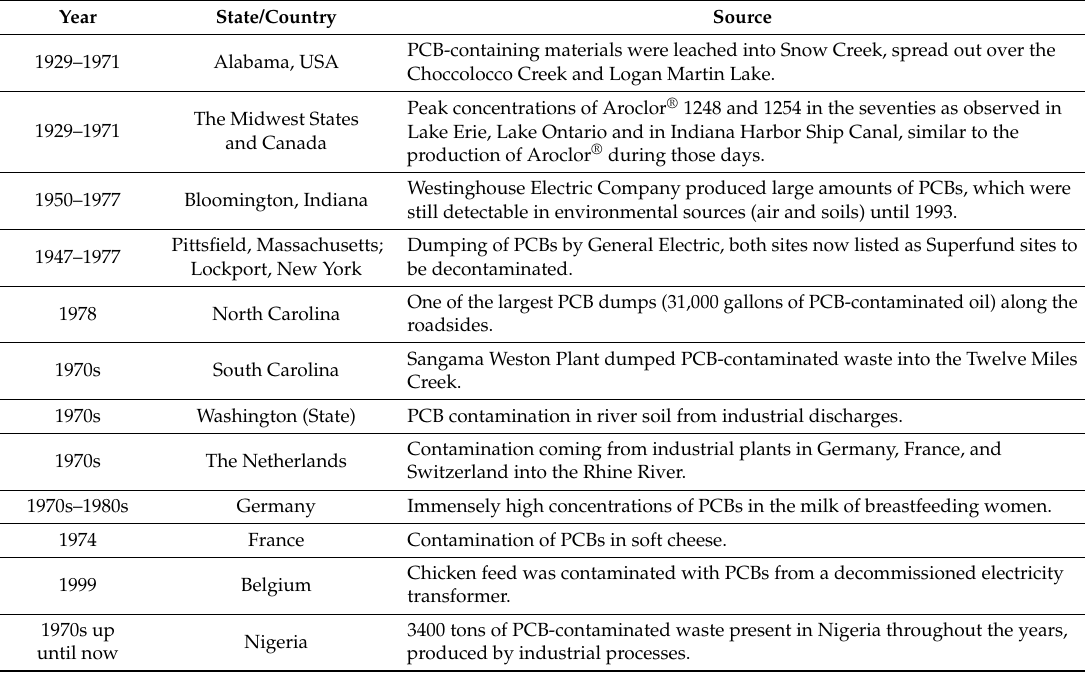
Table 1. Overview of major PCB contamination cases in a series of countries in the 20th